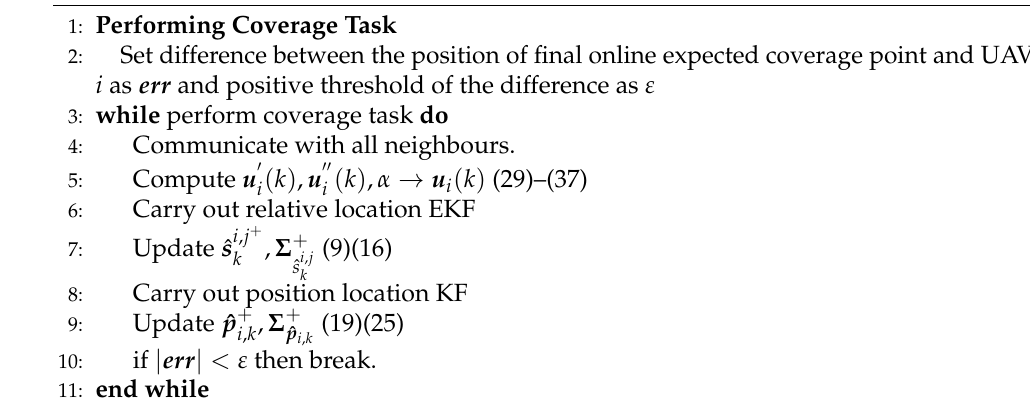
Algorithm 2 Optimal relative location (RL)-based coverage placement